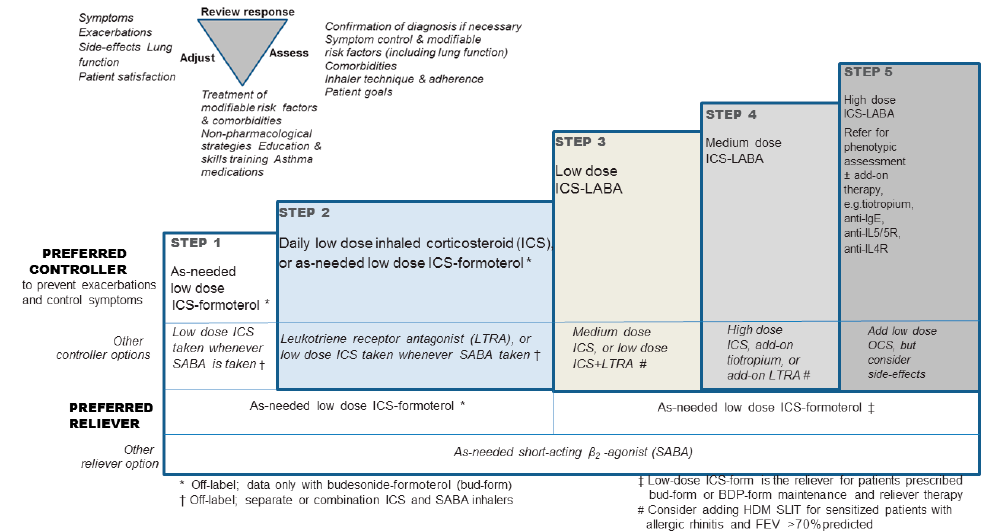
Figure 9. Personalized management for adults and adolescents to control symptoms and minimize future risk [1].